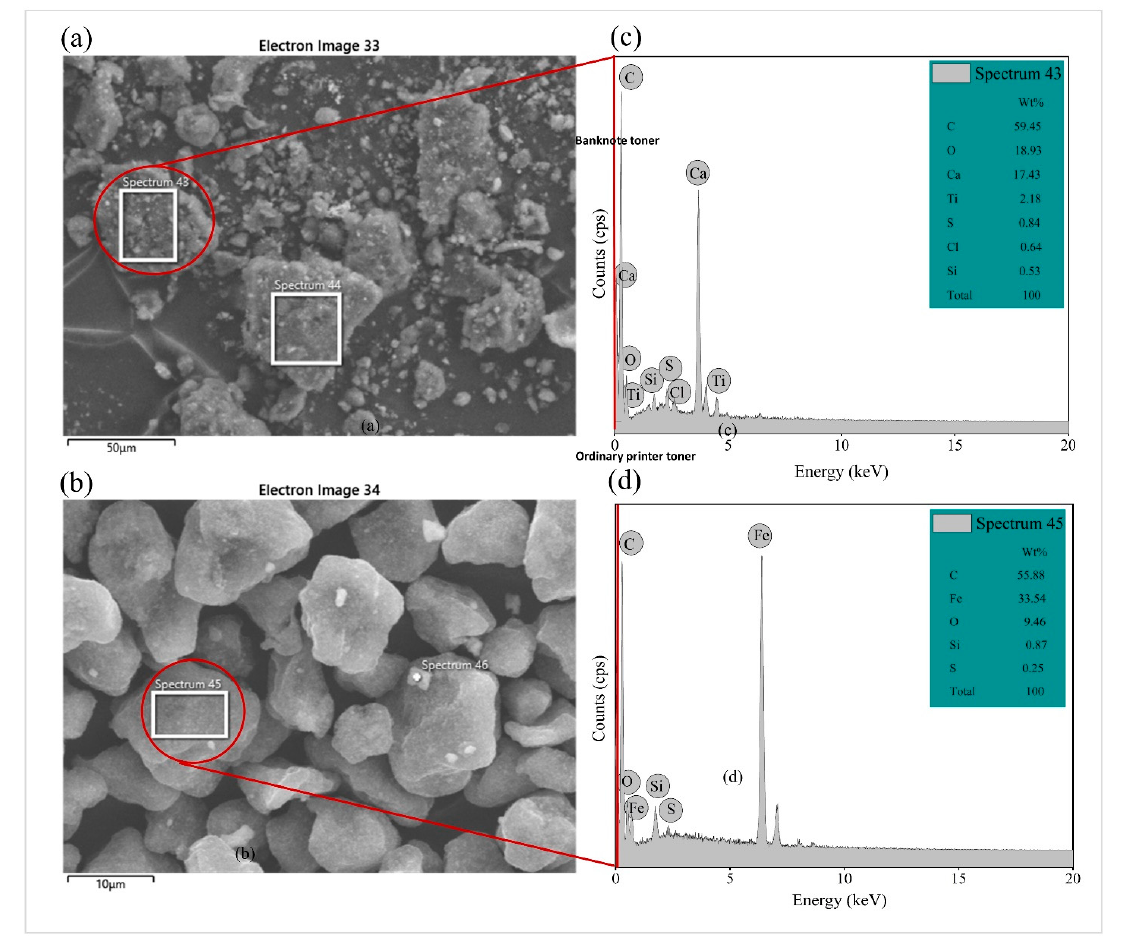
Figure 4. SEM-EDS of the waste toner powders. ( a ) SEM of WBT; ( b ) SEM of WPT; ( c ) EDS of WBT; ( d ) EDS of WPT. Table 2. Components of waste toner.